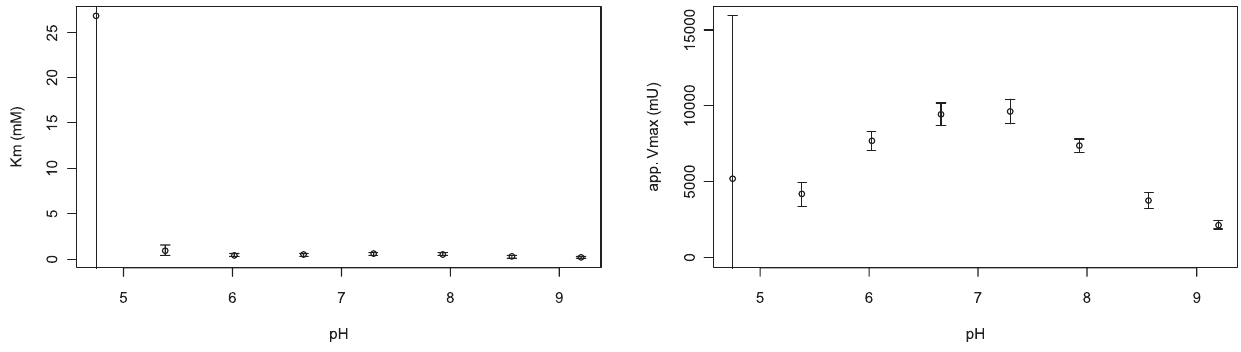
Figure 8. A graphical representation of the apparent Km and Vmax-values determined at different pH. Note the shape of the pH- dependence of Vmax and the high reported uncertainties at pH